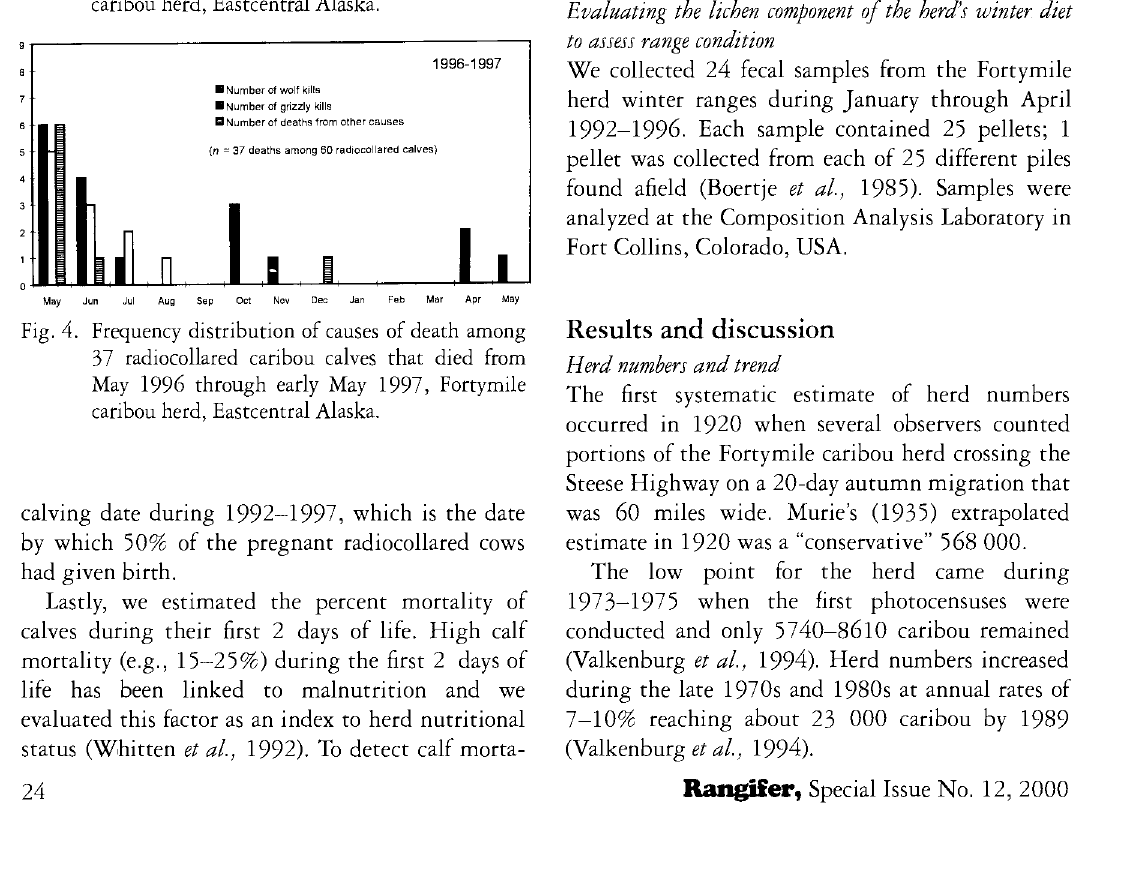
Fig. 3- Frequency distribution of causes of death among 30 radiocollared caribou calves that died from May 1995 through early May 1996, Fortymile caribou herd, Eastcentral Alaska.